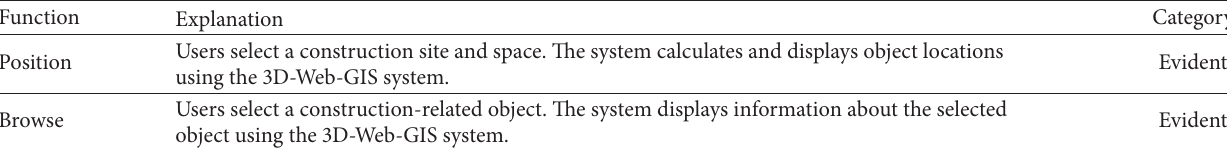
Table 1: Location sensing system functions.